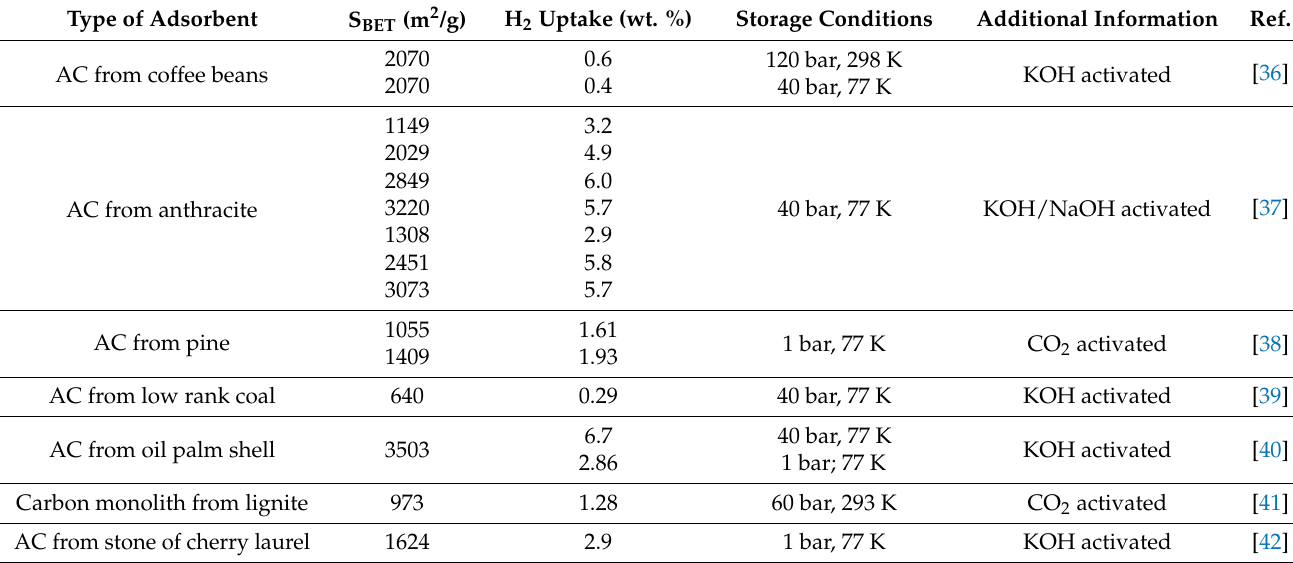
Table 3. Hydrogen storage in various conditions using activated